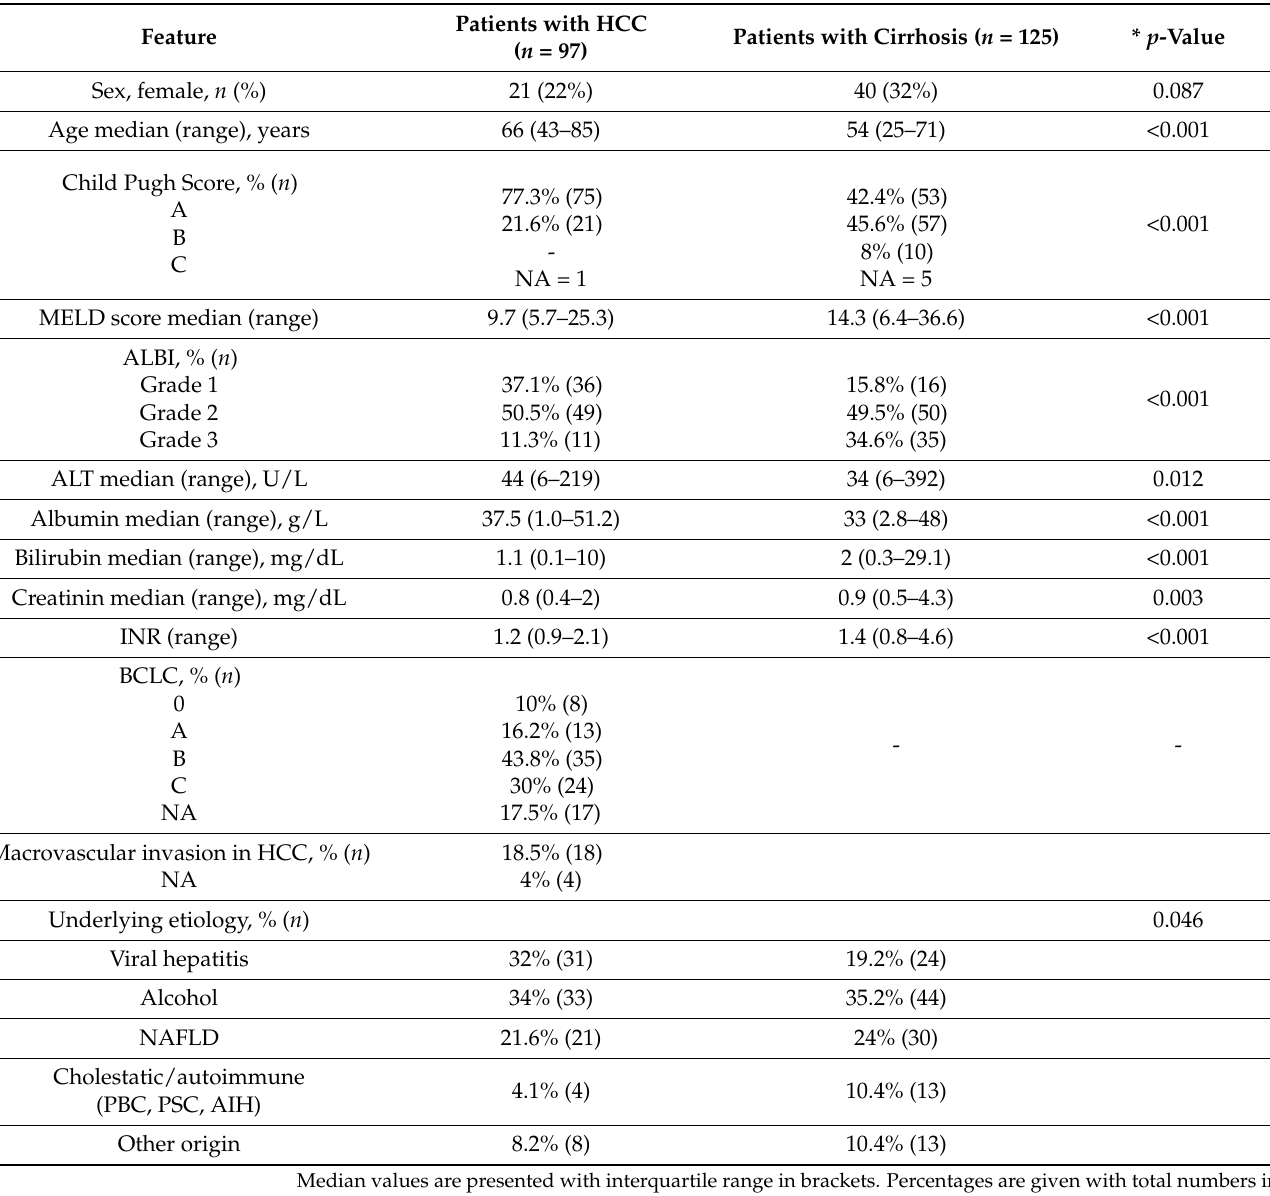
Table 1. Biochemical and clinical features of all patients with cirrhosis with or without